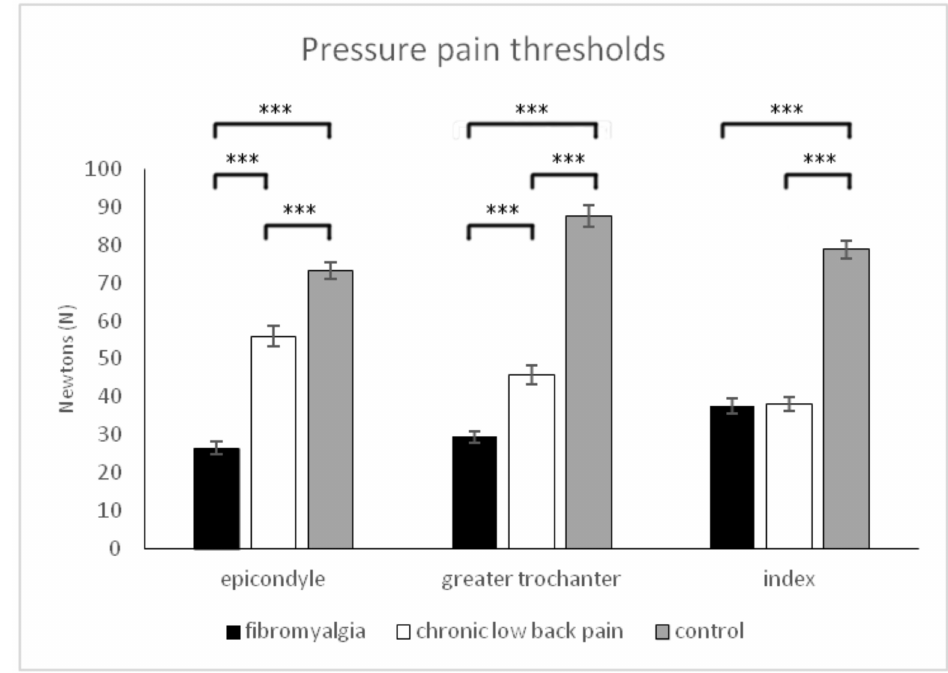
Figure 1. Means and typical errors for pressure pain thresholds at epicondyle, greater trochanter, and index finger in the three groups of participants (fibromyalgia, chronic low back pain and pain-free controls). *** p <